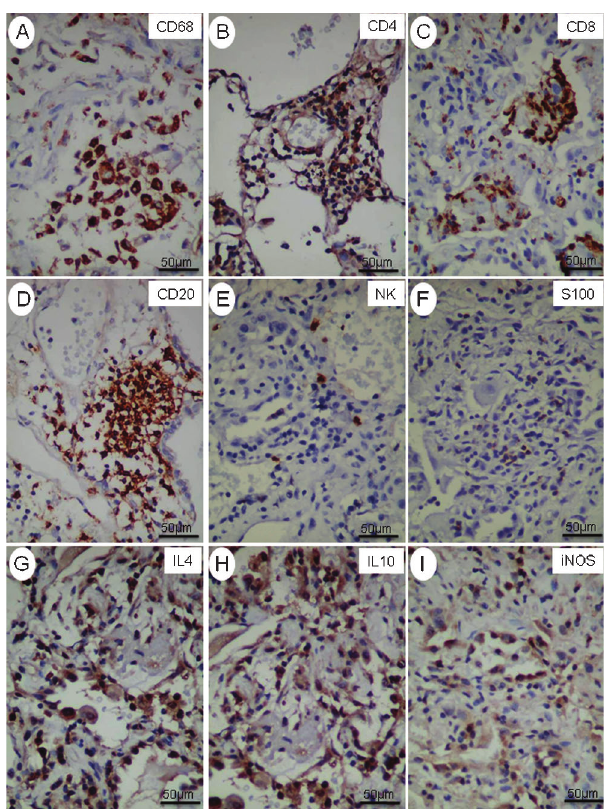
Figure 3 – Immunologic featuresof lungs from N1H1patients. Small aggregates of CD68 (A), CD4 + (B), CD8 + (C), CD20 + (D), NK + (E), and S100 + (F) present around vessels and bronchioles. Note a very strong expression of IL-4 (G), IL-10 (H) and iNOS (I) in macrophages and small mononucleated cells,